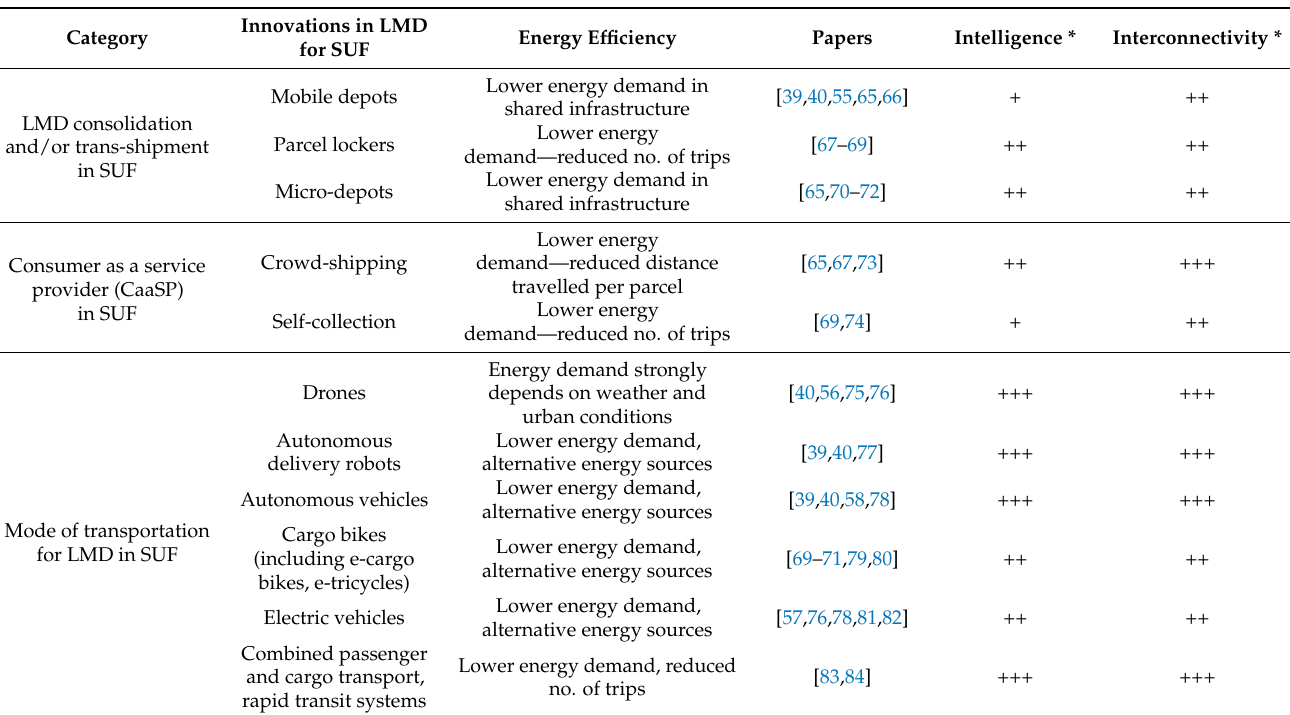
Table 4. Innovations for LMD applied by LSPs for the development of SUF in energy-efficient smart